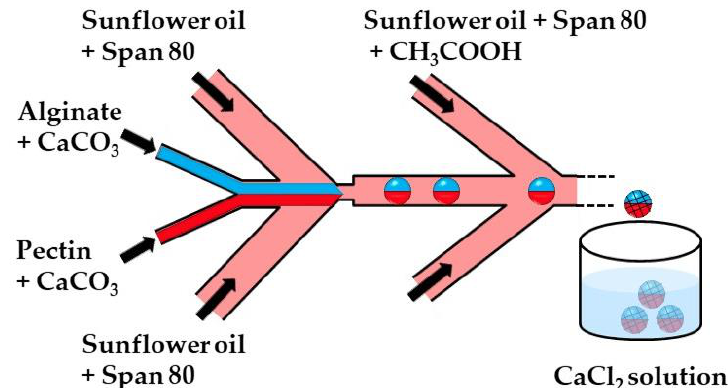
Figure 3. The formation of alginate/pectin Janus beads by internal gelation in the chip consisting of one upstream Y-junction and two downstream Ψ junctions. Aqueous solutions of alginate and pectin are introduced through separate inlet channels of the Y junction to form a co-axial biphasic flow. Janus droplets are formed at the upstream Ψ junction by flow focusing the coaxial jet with an oil phase, and the crosslinking reaction is initiated at the downstream Ψ junction. Because of the laminar flow, the two miscible polymer solutions remain segregated between the two Ψ junctions, enabling a Janus droplet morphology to be preserved after polymer crosslinking. The Janus beads are collected in a CaCl 2 solution to strengthen the gel network structure [32].